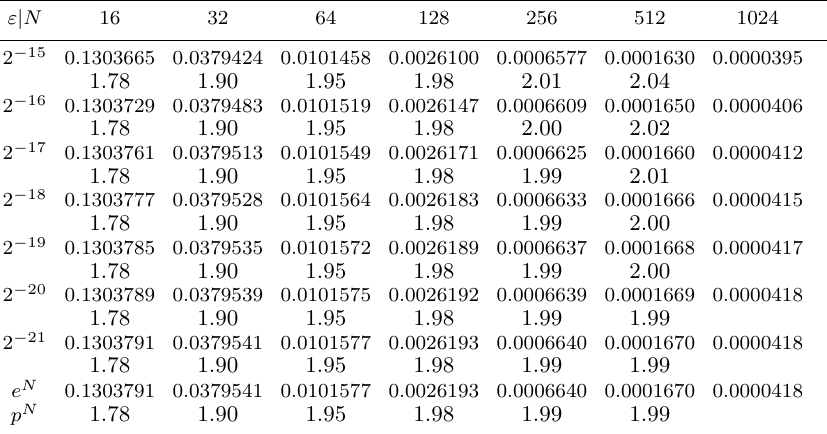
Table 1. Errors e N and rates of convergence p N for test problem. ε |